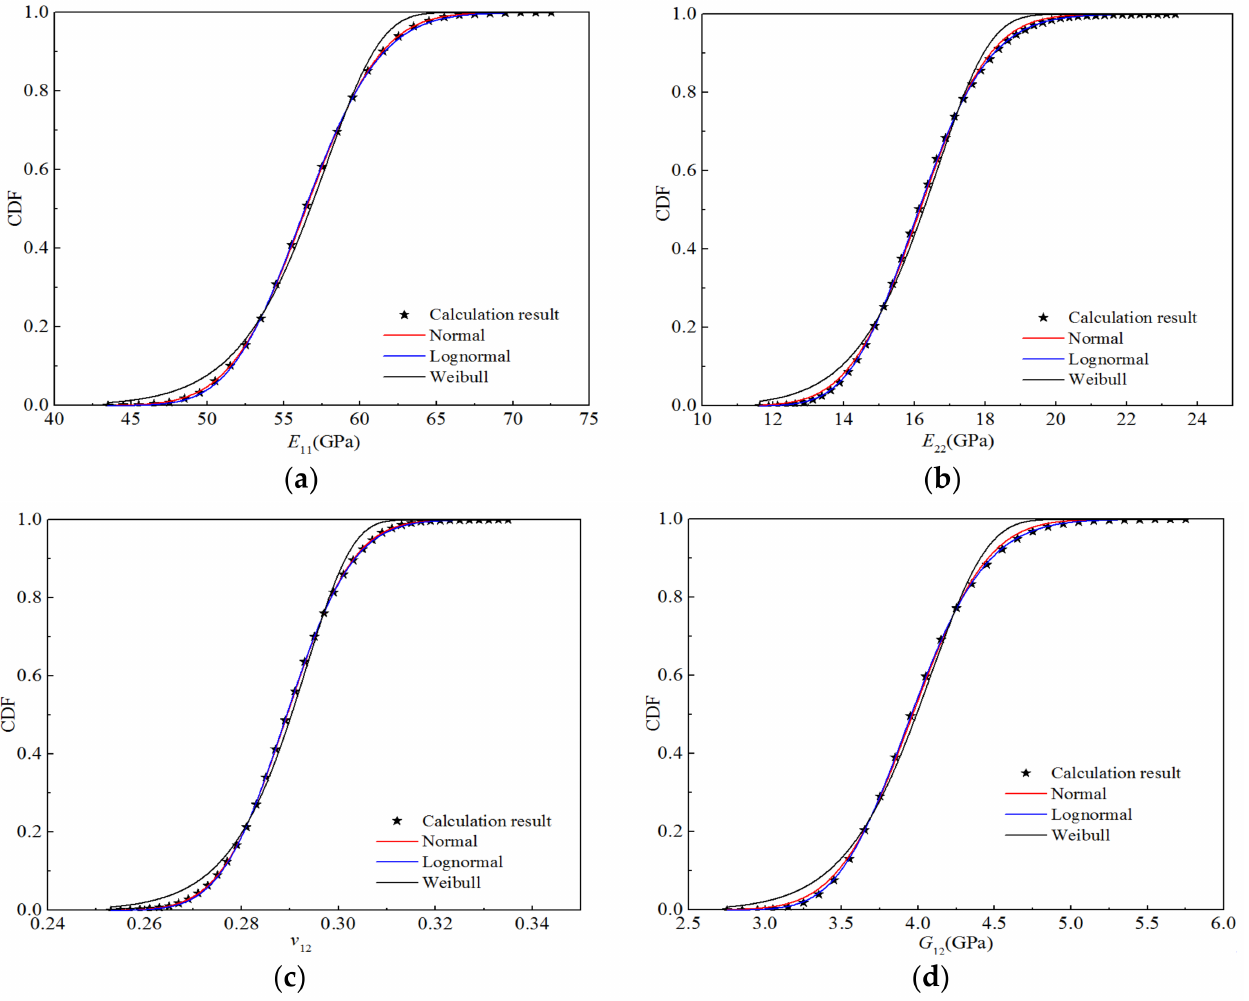
Figure 17. Function fitting curves for the stiffness of H-GFRPs under the RTD condition. ( a ) E 11 , ( b ) E 22, ( c ) v 12 , ( d ) G 12 .